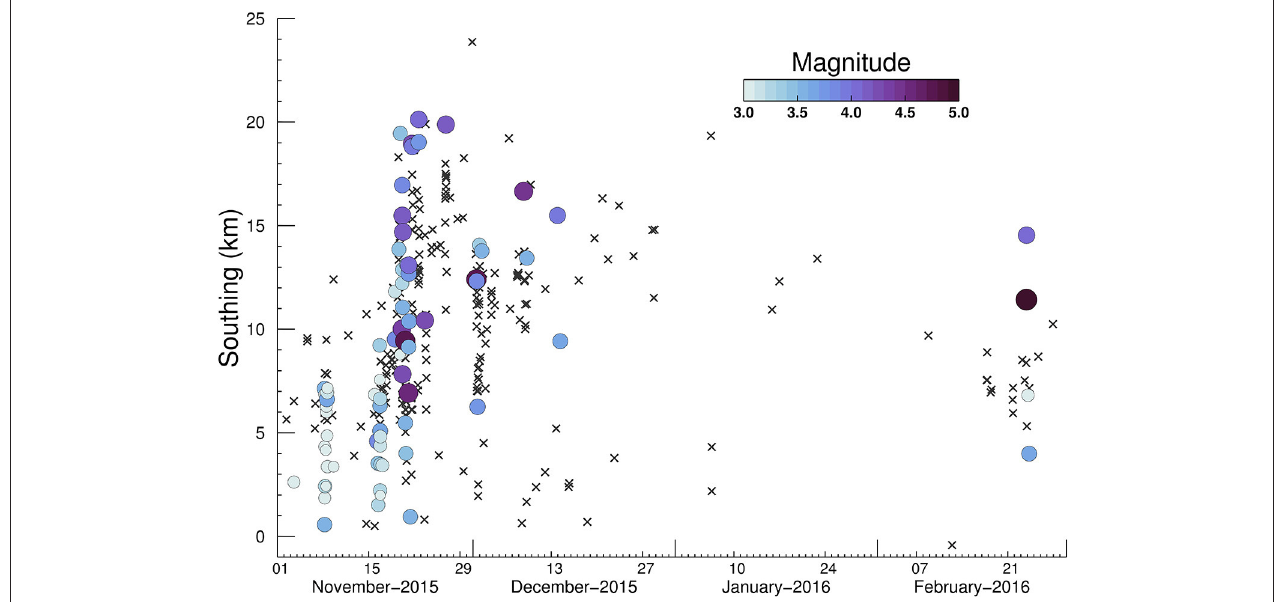
FIGURE 8 | Time–distance plot for the events relocated using the regional network (colored circles) and single-station location (crosses). The distance is measured along the BB’ axis shown in Figure 3 , and the color code and circle size scale with local magnitude calculated on the vertical displacement (M lv ).